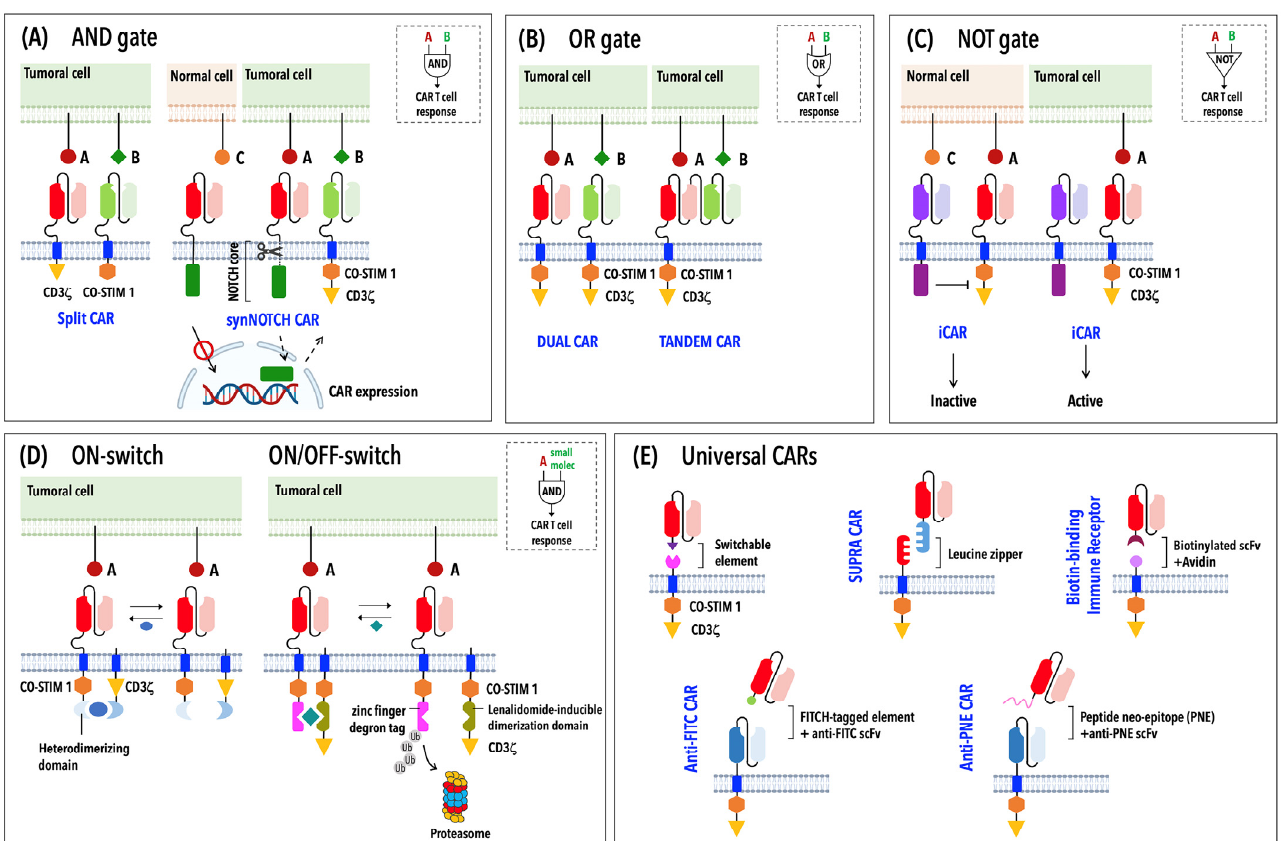
Figure 2. Strategies for the design of new-generation CARs. Schematic representation of logic-gated CARs (AND-, OR- and NOT-gated CARs) ( A – C ), ON-switch and lenalidomide ON/OFF-switch CARs ( D ) and universal CARs ( E ).